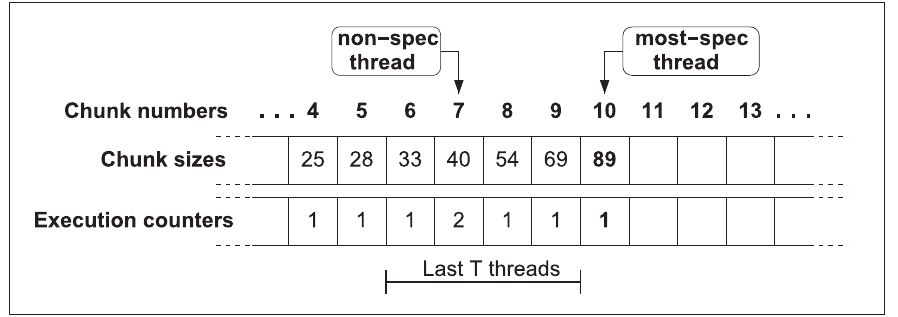
Fig 8. Dynamic Moody Scheduling. The size for the following chunk to be executed (#10 in the example) is calculated once, and its size will be preserved regardless of the number of re-executions of this chunk.